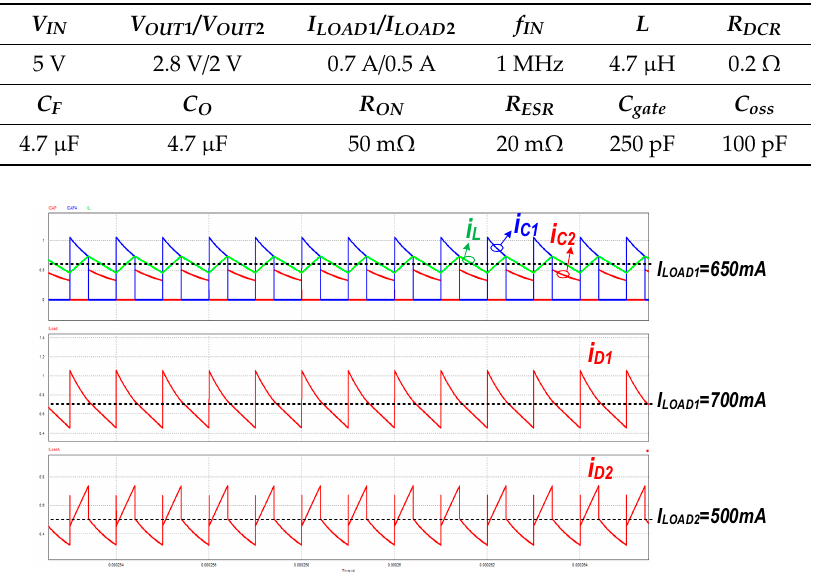
Figure 23. Simulated current waveforms of the proposed single-inductor dual-output converter with ETM (SIDOETM).